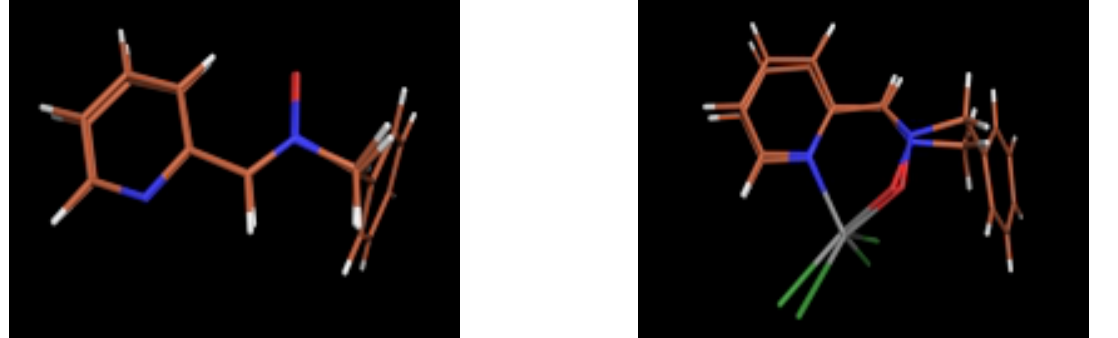
Figure 5. Comparison of the modeled structure of nitrone 2 with the X-ray structure.